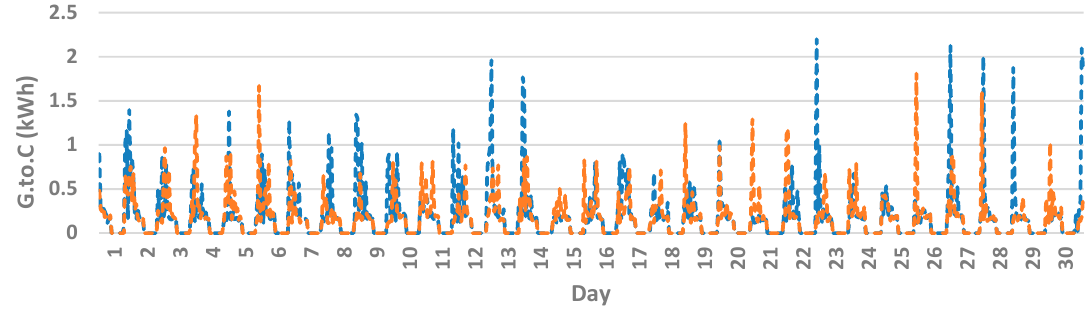
Figure 15. Energy transmission from grid to loads in a system without energy storage, for a single dwelling. Comparison between the most and least probable scenarios (blue and orange) for one month (April). Source: self-elaboration.